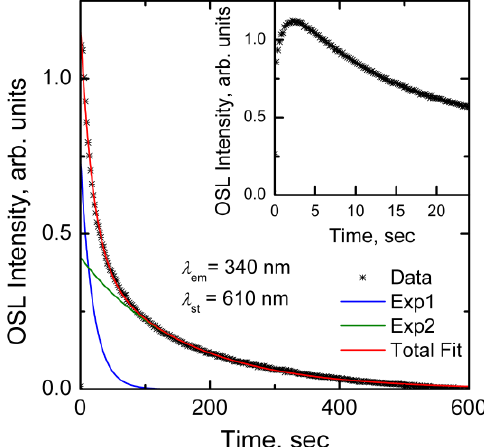
Figure 3. OSL decay curve. The OSL emission monitored is at 340 nm during a stimulation at 610 nm with a constant light intensity. The OSL curve can be approximated mainly by a sum of two exponential decay functions. The inset shows the OSL curve in a shorter time range 0–25 s after the stimulation started.